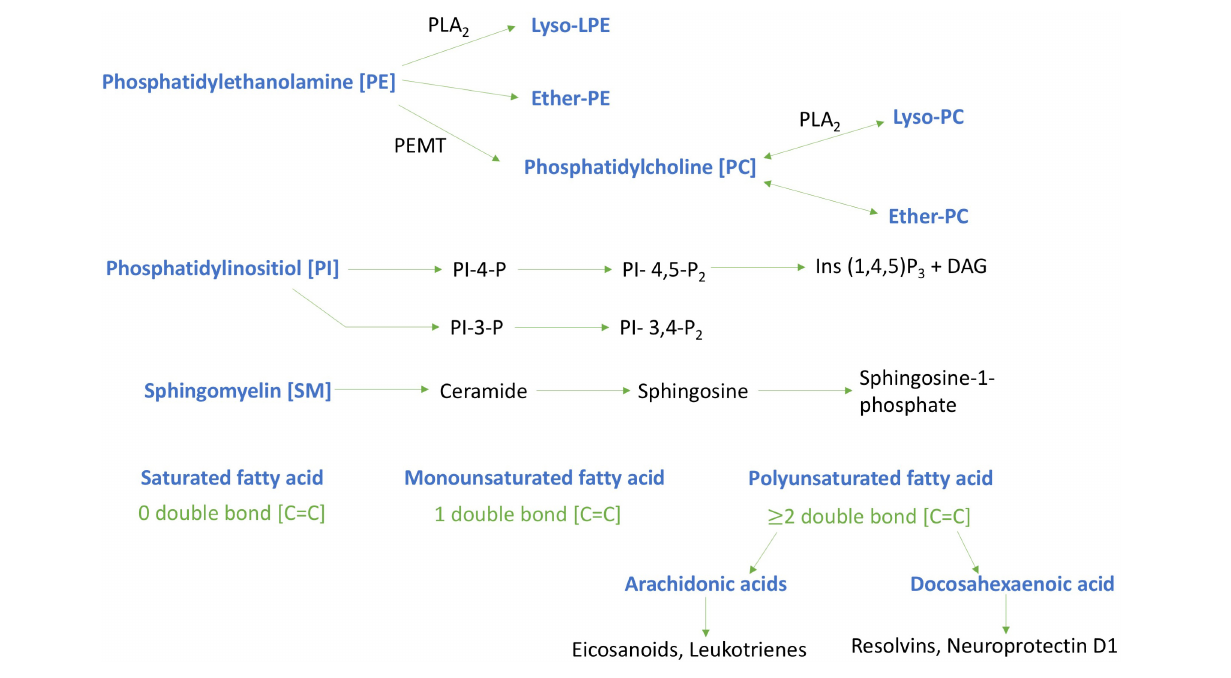
FIGURE 7 | Schematic diagram of key phospholipids investigated and their metabolites. Lipids investigated are highlighted in blue typescript. Phosphatidylinositol - 4 – phosphate [PI-4-P]; Phosphatidylinositol – 4, 5- bisphosphate [PI-4,5-P2]; Inositol trisphosphate [Ins (1,4,5)P3]; Diglyceride [DAG]; Phosphatidylethanolamine N -methyltransferase [PEMT]; Phospholipase A2 [PLA2]; Phosphatidylinositol – 3, 4- bisphosphate [PI- 3,4-P2]; Phosphatidylinositol -3- bisphosphate